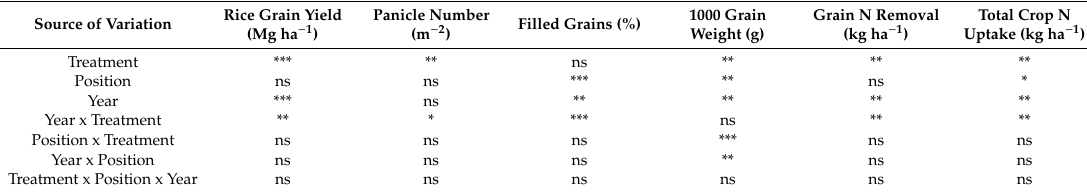
Table 4. Analysis of variance for grain yield, N uptake and yield components (means of the years 2016 and